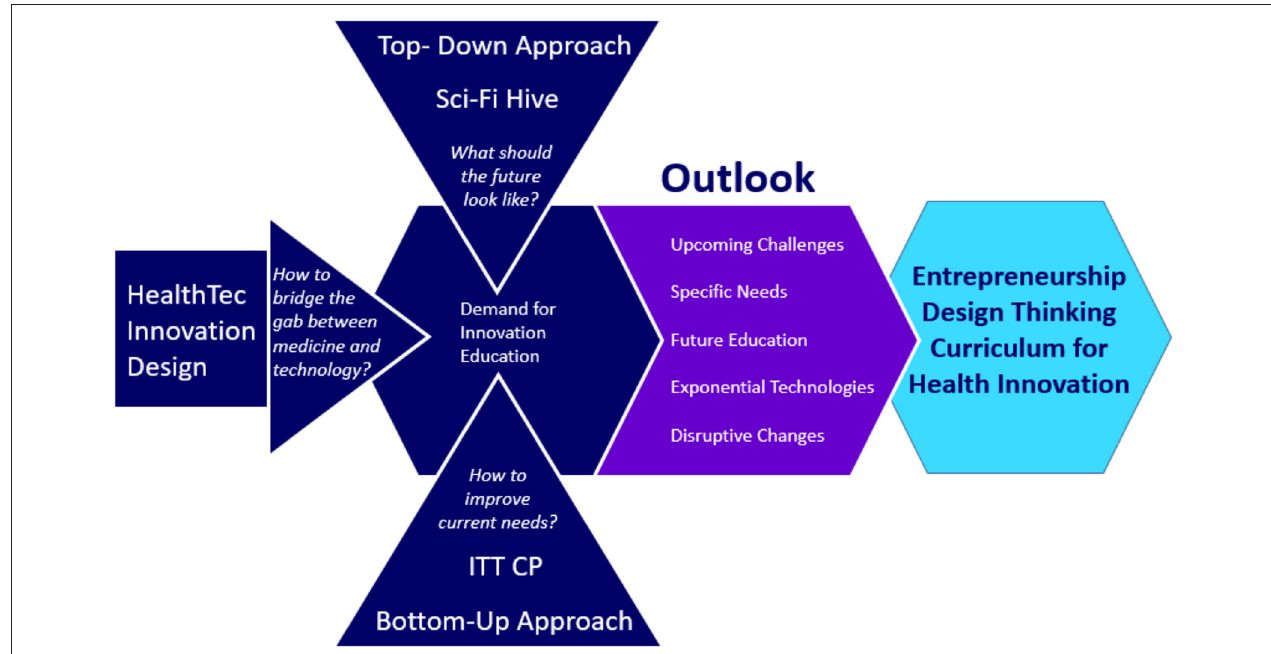
FIGURE 1 | Approaches for a new